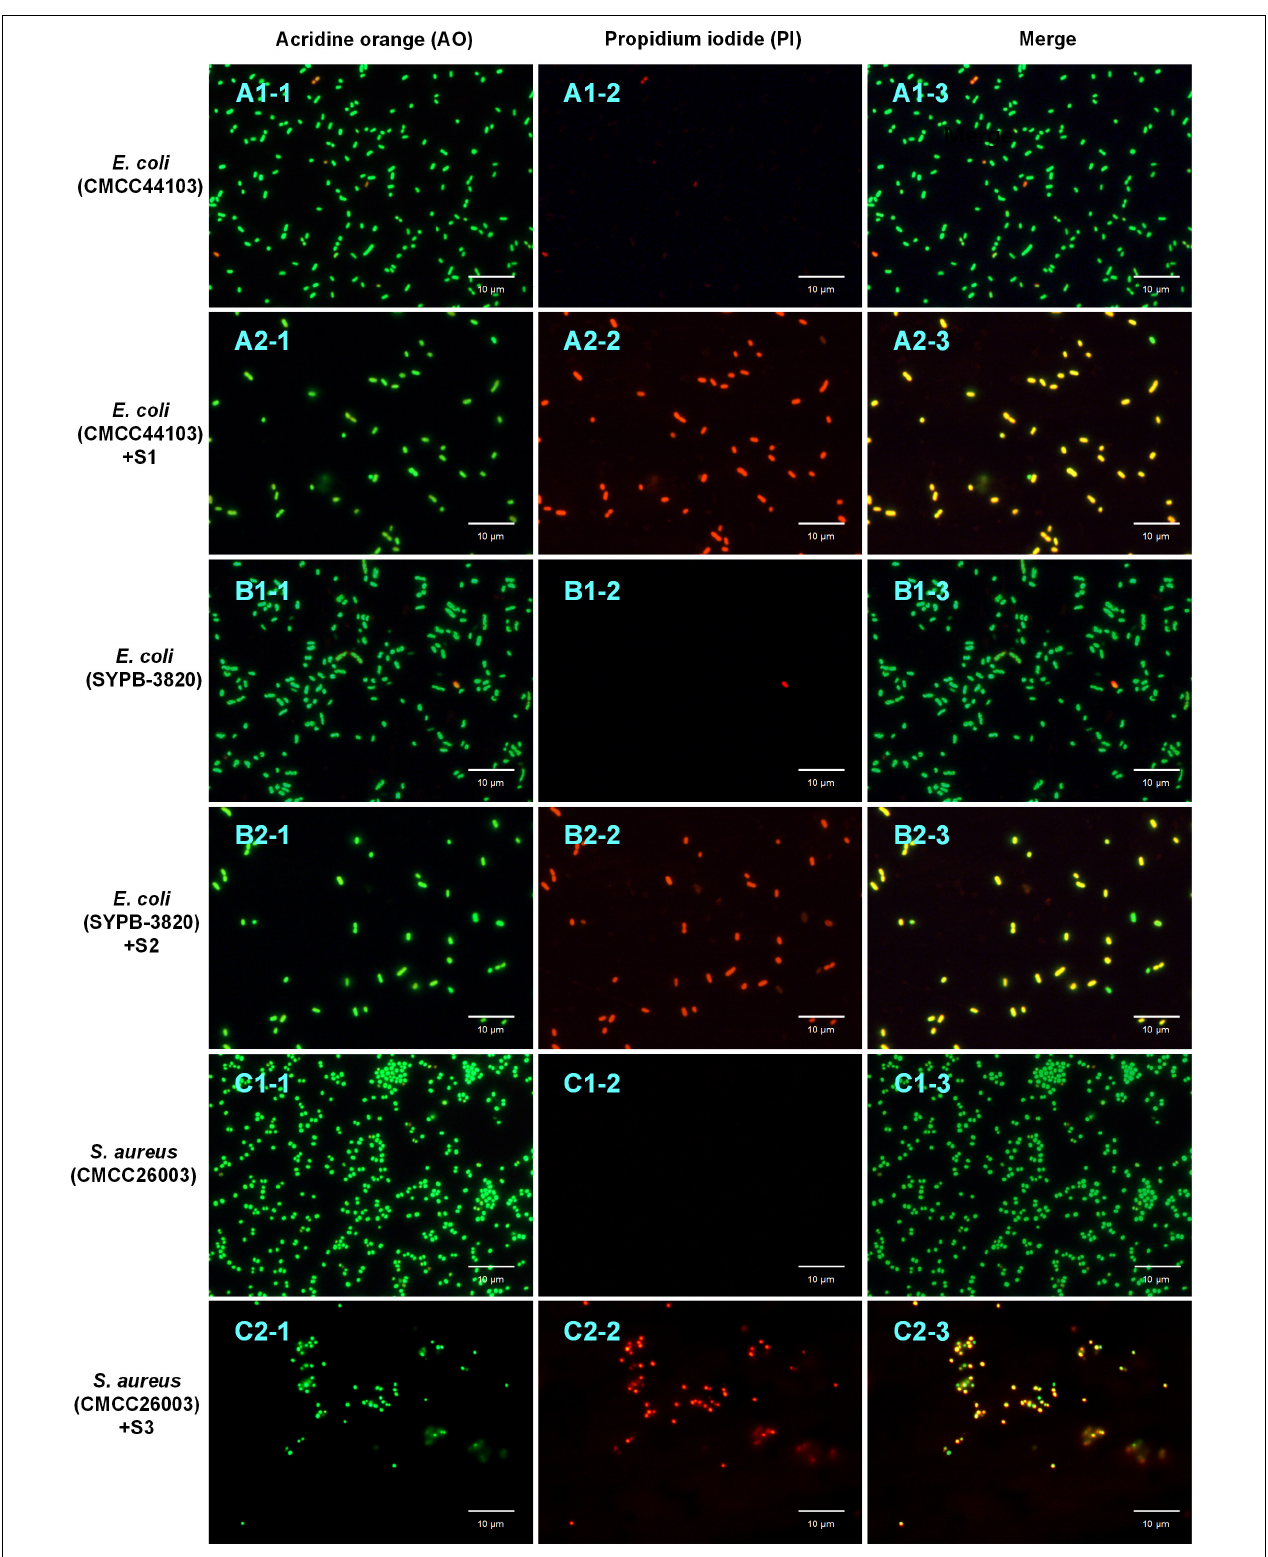
FIGURE 6 | AO/PI double staining assay. The bacteria stained with AO (A1-1,A2-1,B1-1,B2-1,C1-1,C2-1) and PI (A1-2,A2-2,B1-2,B2-2,C1-2,C2-2) were photographed under the excitation of 488 and 535 nm, respectively; the merge (A1-3,A2-3,B1-3,B2-3,C1-3,C2-3) was fusion-fluorescence imaging under the excitation of 488 and 535 nm. The scale bar is 10 µ